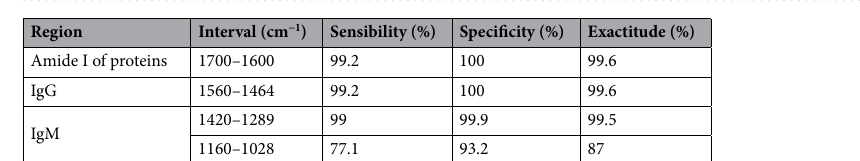
Figure 6. Multiple linear regression model (MLRM) between healthy (N = 1209) and COVID-19 (N = 255) groups in the regions of Amide I, IgG, and IgM. ( A ) Amide I (1700–1600 cm −1 ), the outputs data are very compact for each population, and the distance between them is well defined, allowing their discrimination. Even though some data from the COVID-19 group are badly grouped and located in the healthy group, the MLRM in the amide I was the best region to discriminate COVID-19 from healthy persons. ( B ) IgG (1560–1464 cm −1 ), the depicted data are grouped in two populations, allowing the discrimination between healthy and COVID- 19 groups; nevertheless, some data of both populations are ungrouped, locating COVID-19 data in the healthy group. ( C ) IgM (1420–1289 cm −1 ), the outputs are clustered, but the distance between the groups is not well defined, not allowing the identification of groups. ( D ) IgM (1160–1028 cm −1 ), the outputs of both populations lump together; moreover, none demarcation line between the groups is observed, mixing the healthy and COVID-19 populations.